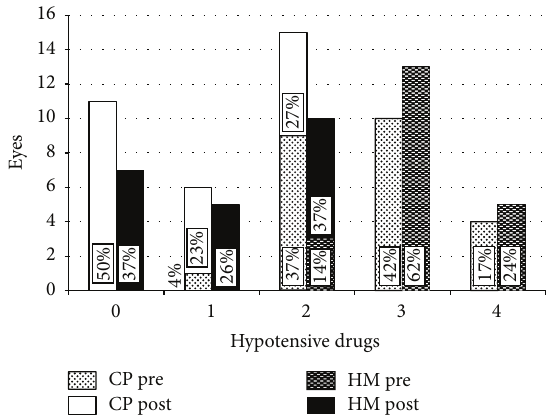
Figure 2: Distribution of eyes (eyes) referred to the number of required hypotensive medications (hypotensive drugs)in each treat- ment group, preoperatively and at the end of the 2-year follow-up. CP pre: preoperative distribution of eyes addressed to